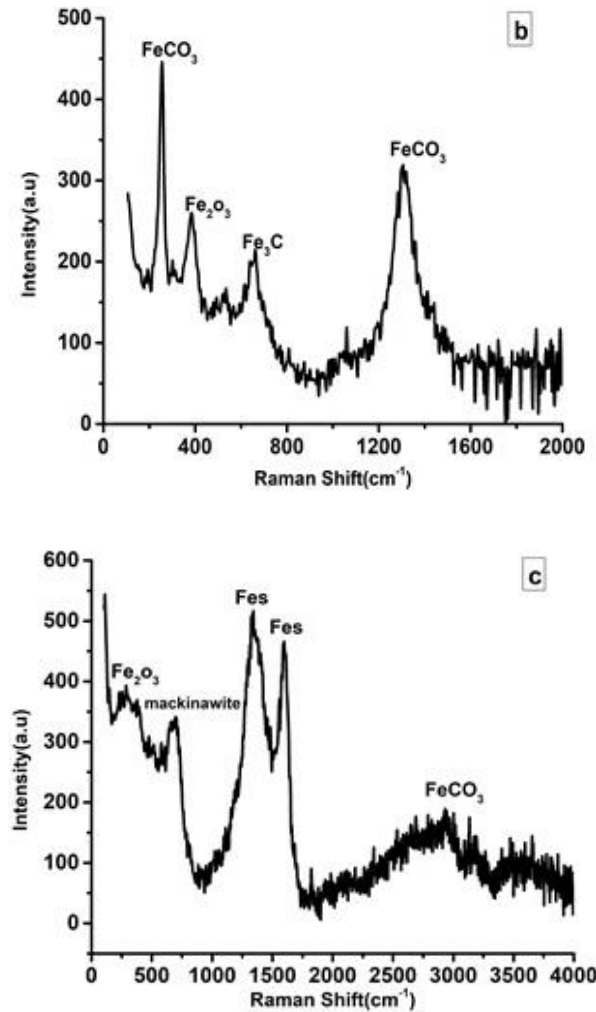
Figure 7. Raman spectroscopy after a potentiodynamic polarization test in pH7 for three different solutions: ( a ) 3.5% NaCl solution, ( b ) 3.5 % NaCl + CO 2 environment, ( c ) 3.5% NaCl + CO 2 + H 2 S environment.